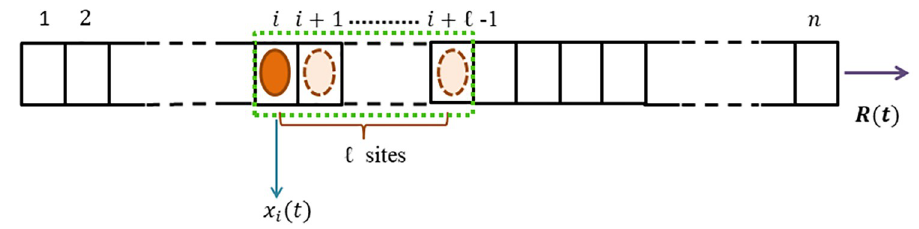
Fig 1. A schematic view of a single particle of size ℓ at site i covering sites i , i + 1, ... , i + ℓ − 1 on the lattice of dimension n. The state variable x i ( t ) describes the reader density of particle at site i at time t . R ( t ) denotes the output rate at time t .